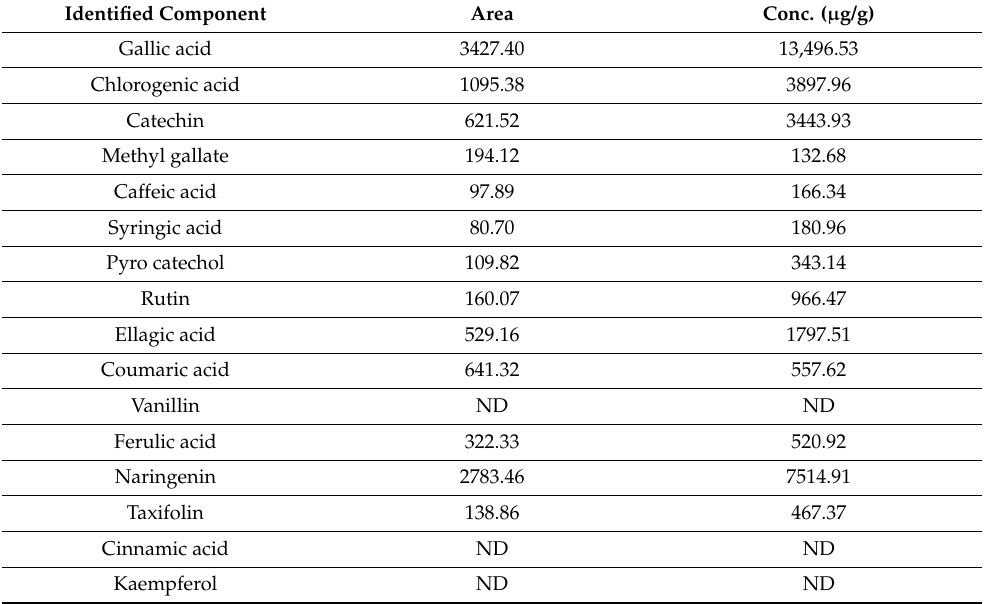
Table 1. RP-HPLC analysis of phenolics and flavonoids components of the aqueous leaves extract of P. dioica .